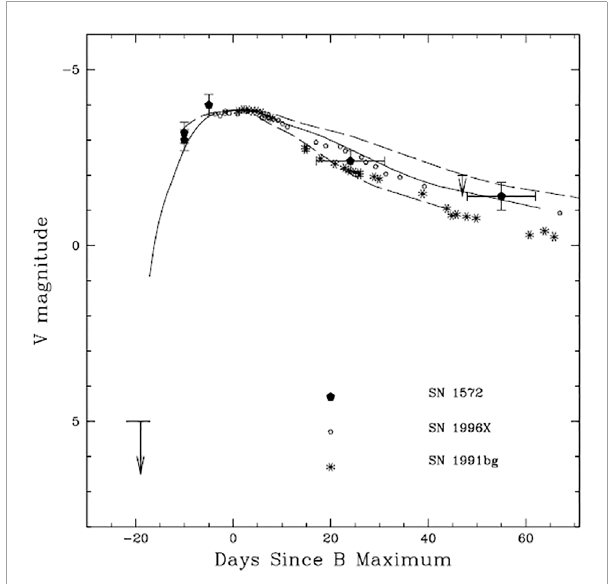
FIGURE 2 The visual light curve of SN 1572 till 60 days. The solid curve is the V light curve of a s = 0.9 SN Ia, which gives the best account for the decline. Such stretch factor is typical of normal SNe Ia. We show for comparison the V light curve of the normal SN Ia SN 1996X, whose stretch factor is s = 0.889 and of the fast–declining SN 1991bg. SN 1572 was significantly slower than SN 1991bg. The light curves plotted in dashed lines are the templates of 91bg–type events and 91T–like events, which depart significantly from the data. Figure in R04. © AAS. Reproduced wih permission.